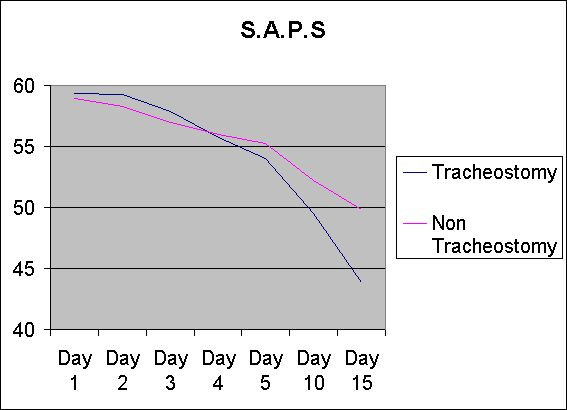
The SAPS score of the two groups (tracheostomized and non-tracheostomized) from day 1 to days 15.